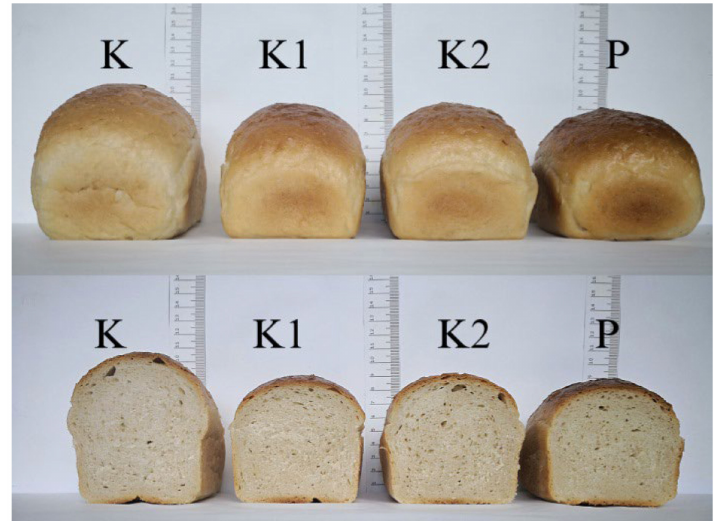
Figure 1. Photographs of bread with S. cerevisiae supplemented with magnesium ions. Control samples of the bread with yeast: K, dry yeast; K1, without magnesium and PEF treatment; K2, with magnesium and without PEF treatment; P, with magnesium and PEF